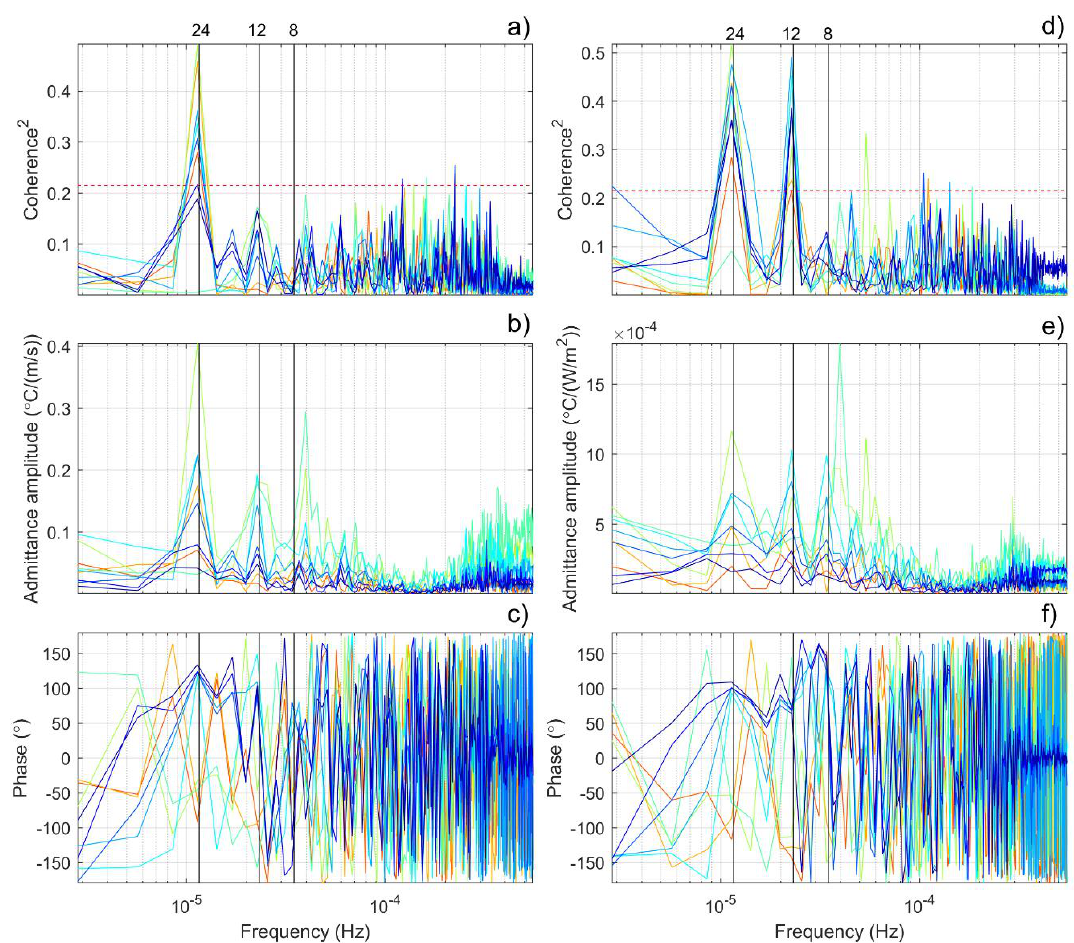
Figure 9. Transfer functions for wind and shortwave radiation time series (input) with water temperature time series (output). The data from 1 September to 22 November was used for the water temperature spectral. The colored lines correspond to the thermistor depths. For wind and temperature, ( a ) square coherence (the dash red line is the 95% confidence), ( b ) admittance amplitude (the gain) and ( c ) phase. For shortwave radiation and temperature, ( d ) square coherence, ( e ) admittance amplitude and ( f ) phase.